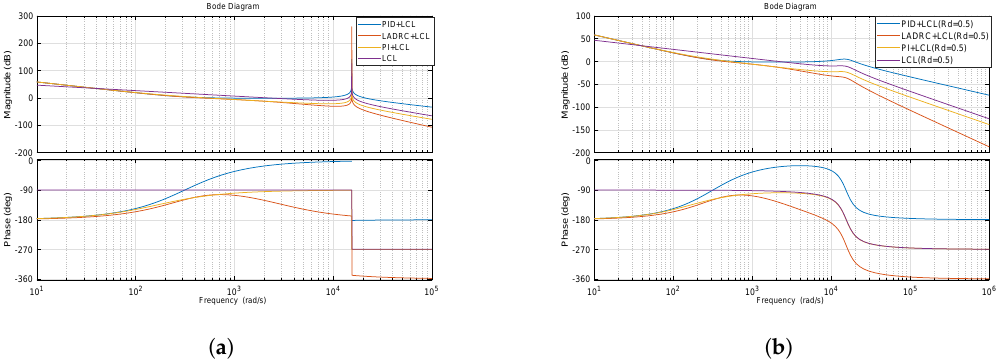
Figure 7. ( a ): Bode diagram of LCL in series with different controllers; ( b ): Bode diagram of LCL with passive damping resistance in series with different